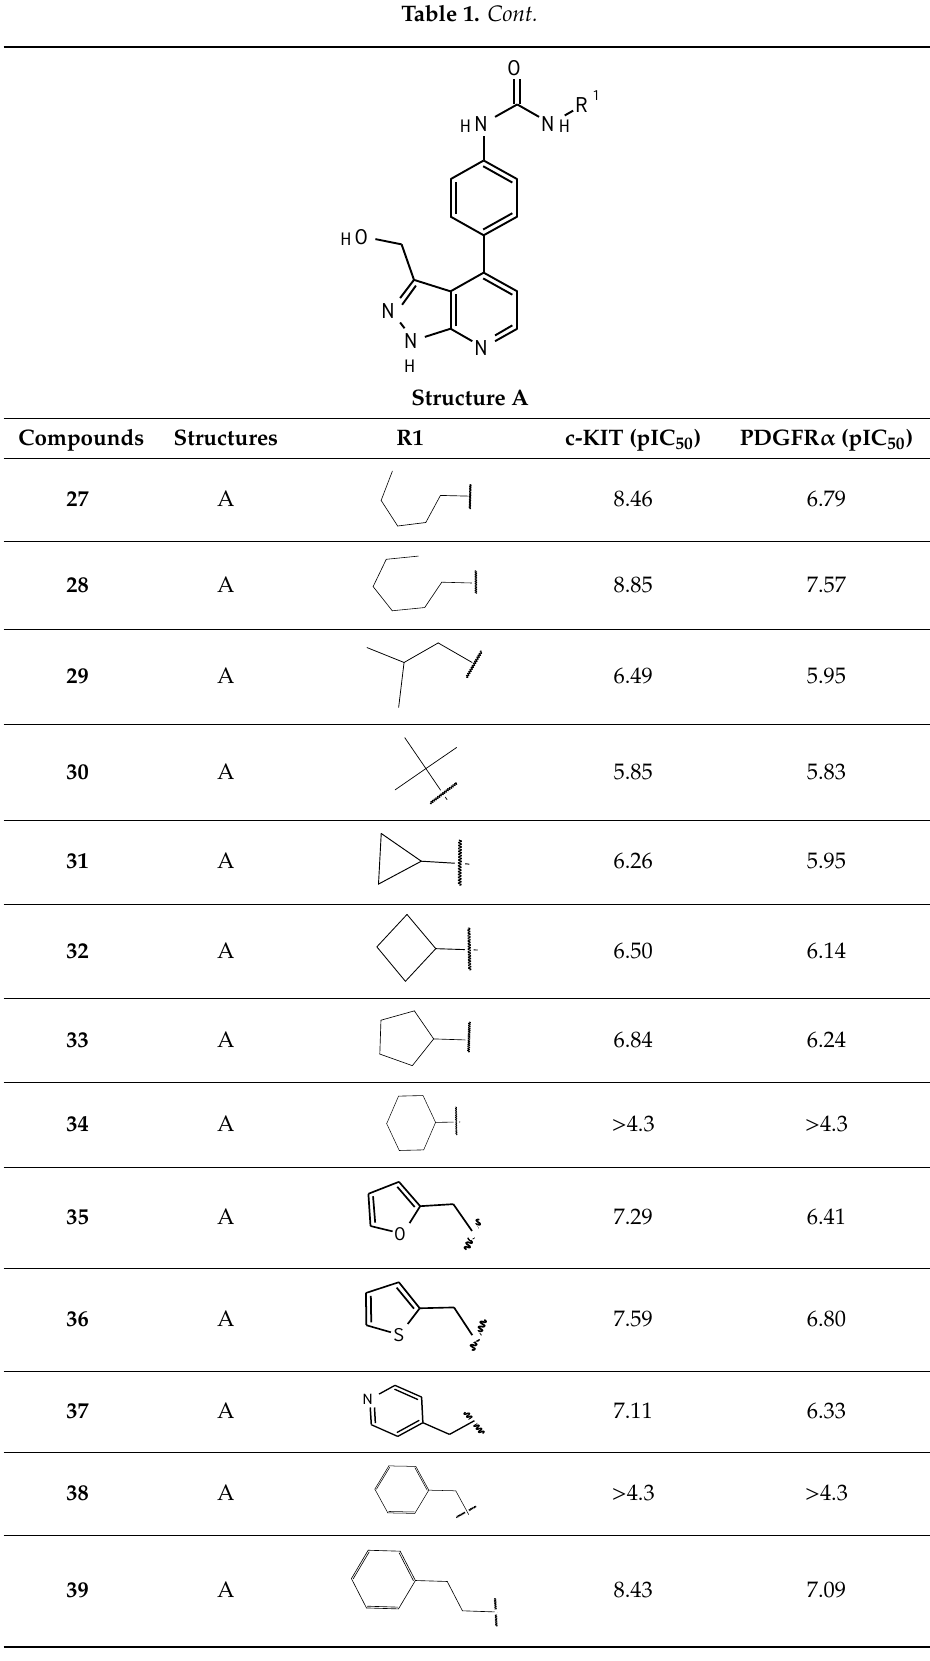
Table 1. Structure of the pyrazolopyridine derivatives and their pIC 50 values for stem cell factor receptor (c-KIT) and platelet-derived growth factor receptor alpha